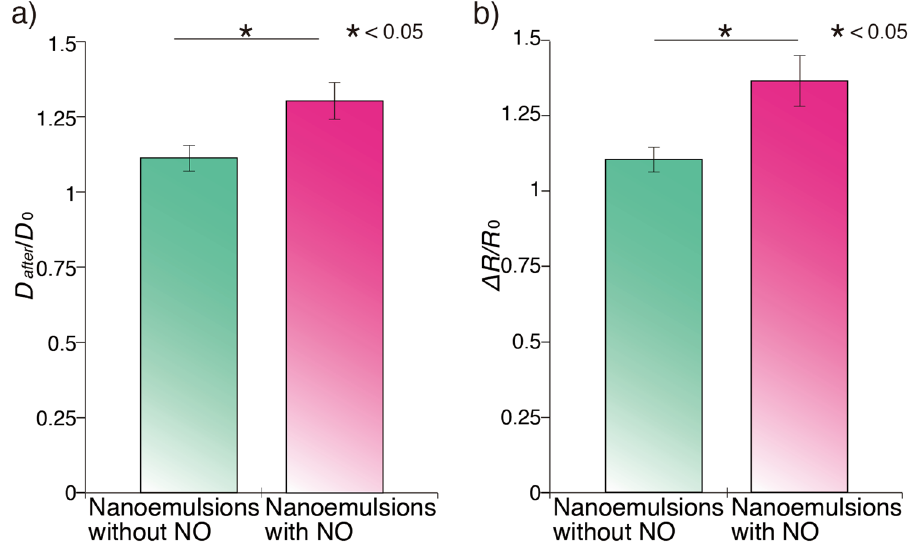
Figure 5. ( a ) Diameter change of the penis after application of the NE without and with NO. The increase of diameter after application of the NE with NO was significantly higher than the penis treated with the oil without NO (D 0 : Diameter of penis without application of oil). ( b ) Redness value of the penis after application of the NE without and with NO (R 0 : Redness value of penis without application of